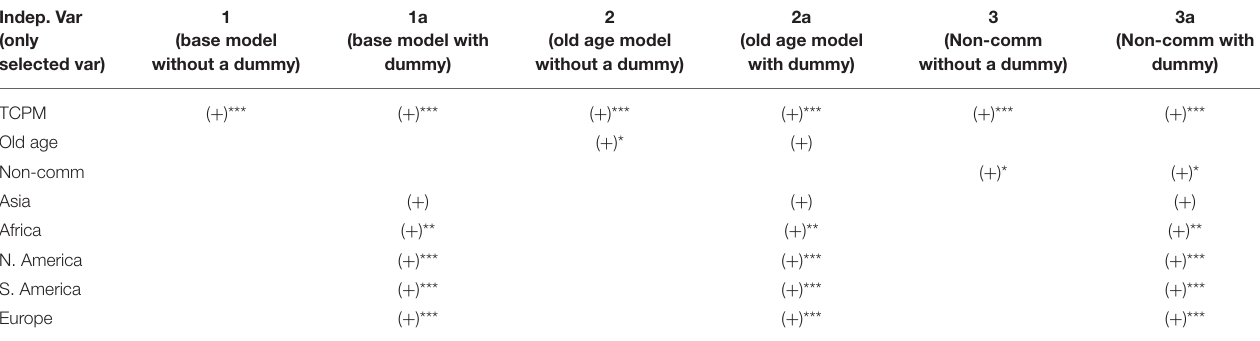
TABLE 11 | Determinants of COVID-19 death at a glance (dependent variable: total death per million of population). Indep. Var (only selected